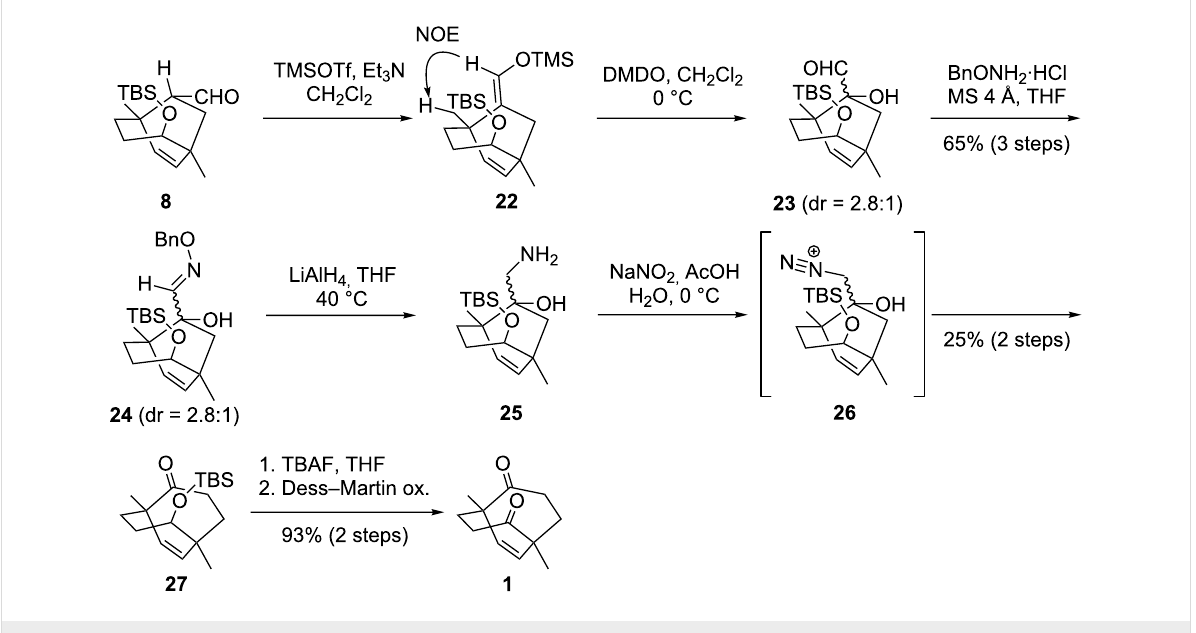
Scheme 5: Synthesis of C 2 -symmetric 1